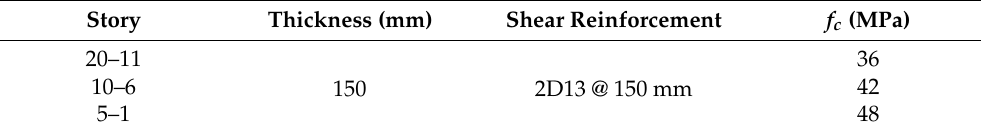
Table 3. Structural parameters of RC walls.